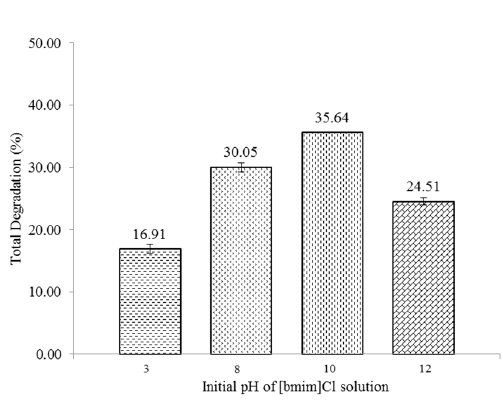
Figure 6. Efficiency of [bmim]Cl photodegradation system at different initial pH of [bmim]Cl solution.